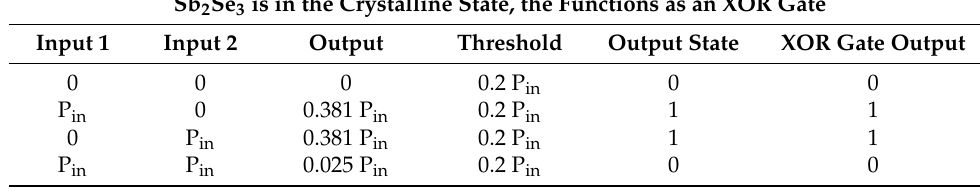
Table 1. Truth table for the all-optical XOR logic gate. Sb 2 Se 3 is in the Crystalline State, the Functions as an XOR